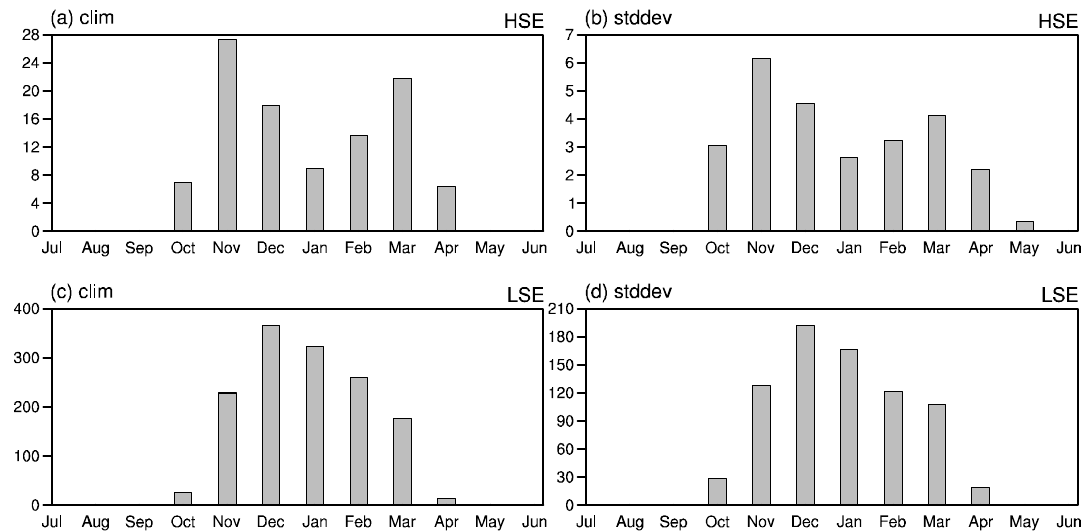
Figure 2. Annual cycles for the ( a , c ) climatology (units: day) and ( b , d ) standard deviation (units: day) of ( a , b ) HSE and ( c , d ) LSE in NEC during 1961–2017. First, we obtained the cumulative snowfall frequency of each station in NEC, and then computed the climatology and standard deviation of each month.